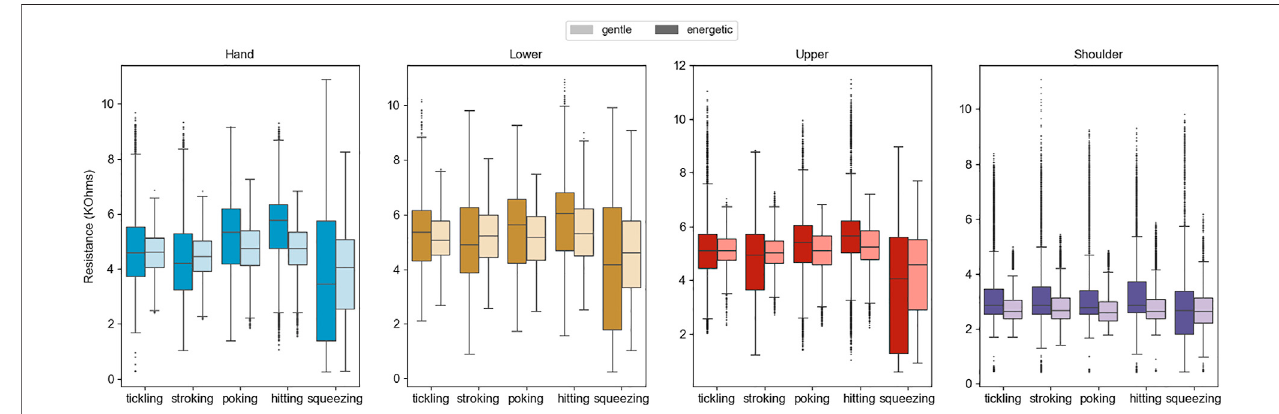
FIGURE 8 | Box-and-whisker plots indicating the range of sensor resistance readings during all participants ’ cumulative gesture performances. Gentle trials are shown in a pale color directly next to the more darkly colored energetic trials of the same type.